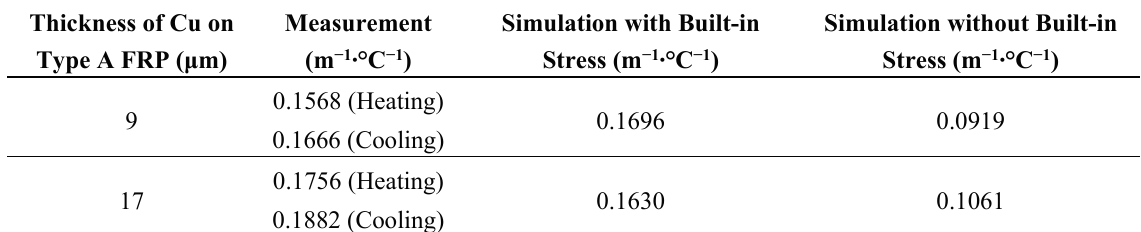
Figure 6. Maximum principal curvature comparison of type A FRP specimens among experimental measurement, simulation results with and without built-in stress: ( a ) type A specimens with 9 μ m Cu; ( b ) type A specimens with 17 μ m Cu, and maximum principal curvature at room temperature with ( c ) 9 μ m Cu and ( d ) 17 μ m Cu films. Table 2. The comparison of the dC / dT values for measurement, simulation with and without built in stress of type A FRP